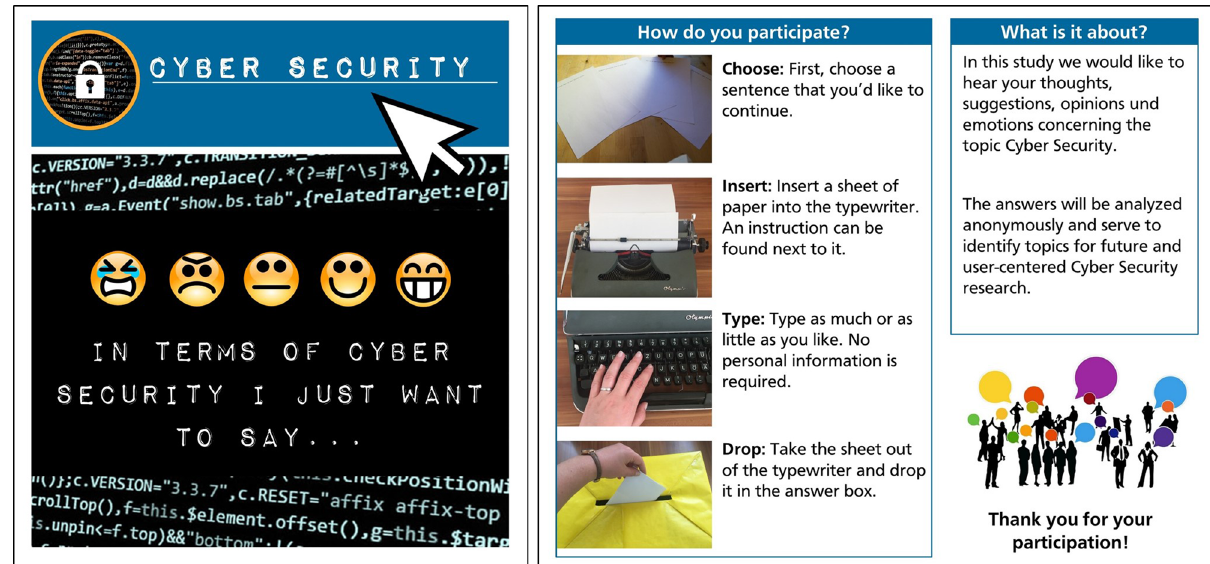
Fig. 7 Anonymized versions of the attention-catching and instruction posters used in the main study. Images used on the posters were from www.